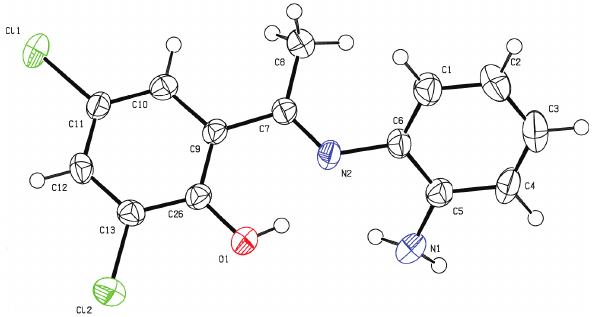
Table 2: Fractional atomic coordinates and isotropic or equivalent isotropic displacement parameters (Å 2